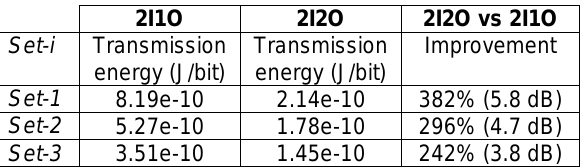
Table 3. Transmission Energy per Bit Comparison between 2I1O and 2I2O at Distance 4 m.